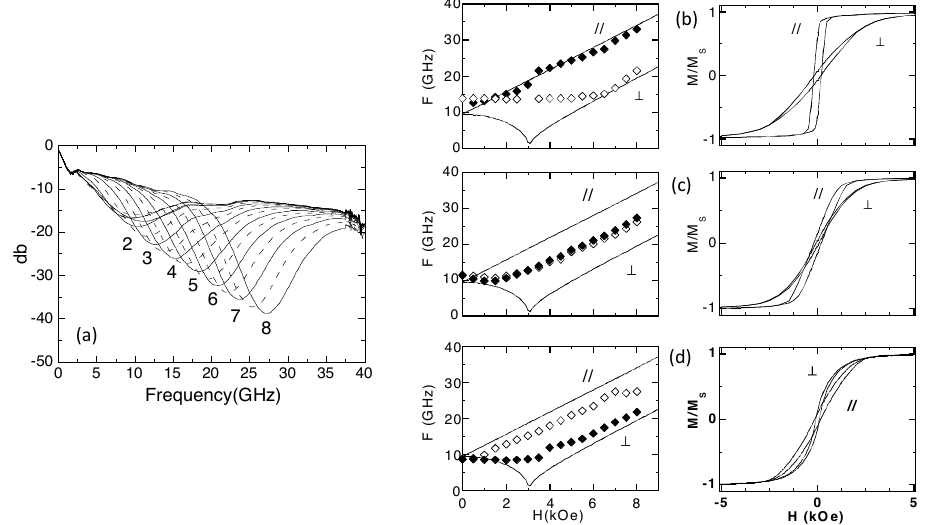
Figure 6. ( a ) microwave absorption spectra as a function of the applied field parallel to the wires of an array of Ni nanowires of diameter 100 nm and packing density of 27%. Continuous lines correspond to measurements made with the applied field value indicated by the numbers; ( b – d ) dispersion relations and the corresponding hysteresis loops measured in arrays of Ni nanowires with the field applied parallel (closed symbols) and perpendicular (open symbols) to the wires. The wire diameter and packing density are ( b ) 180 nm, 4%, ( c ) 100 nm, 27%, and ( d ) 115 nm, >35% (from